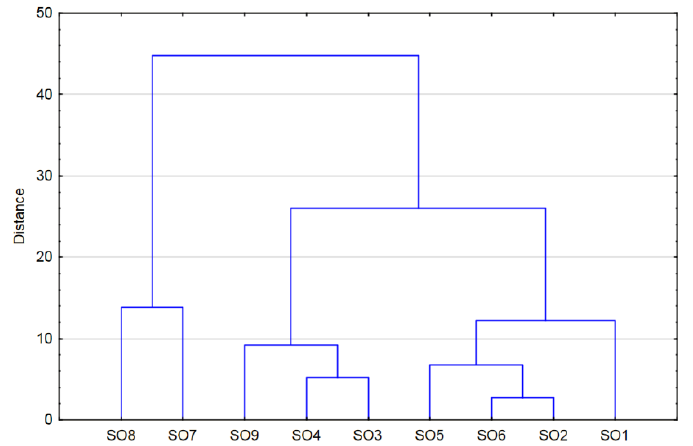
Figure 1. Dendrogram of cluster analysis.